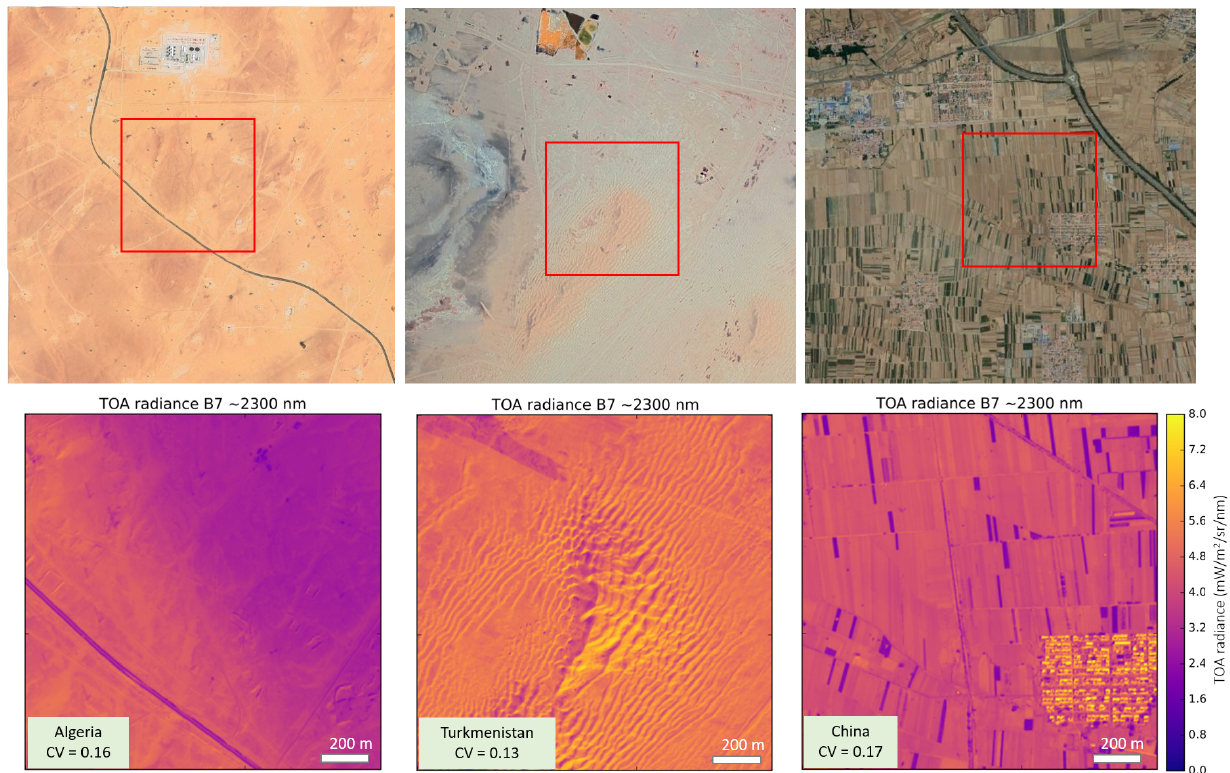
Figure 5. Sites considered for end-to-end simulations. Top panels represent the sites in RGB color from © Google Earth imagery (at earlier dates). The areas defined by a red square of 1.5 × 1.5km 2 (406 × 406 pixels) are the WV-3 SWIR subsets used as input for the sensitivity analysis and where simulated plumes have been added. The © WV-3 SWIR B7 subsets are displayed at the bottom row and the values of the coefficient of variation (CV; standard deviation over mean) are labeled for each